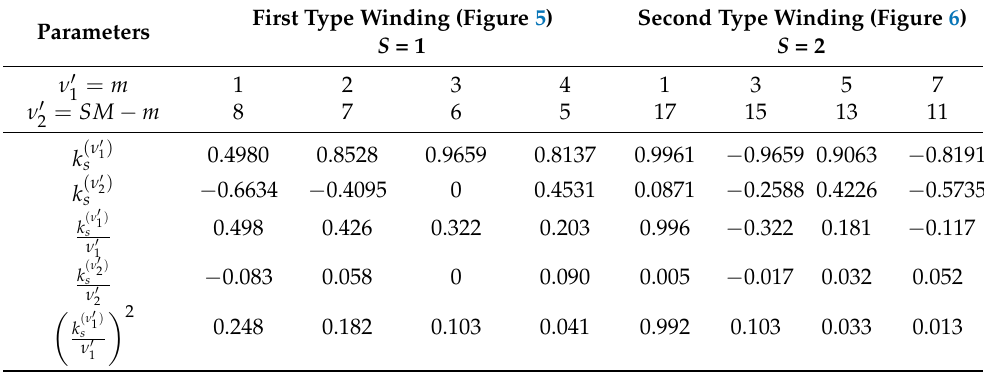
Table 1. Coefficients of the MMF amplitudes and the amplitude of induced phase voltages for the nine-phase